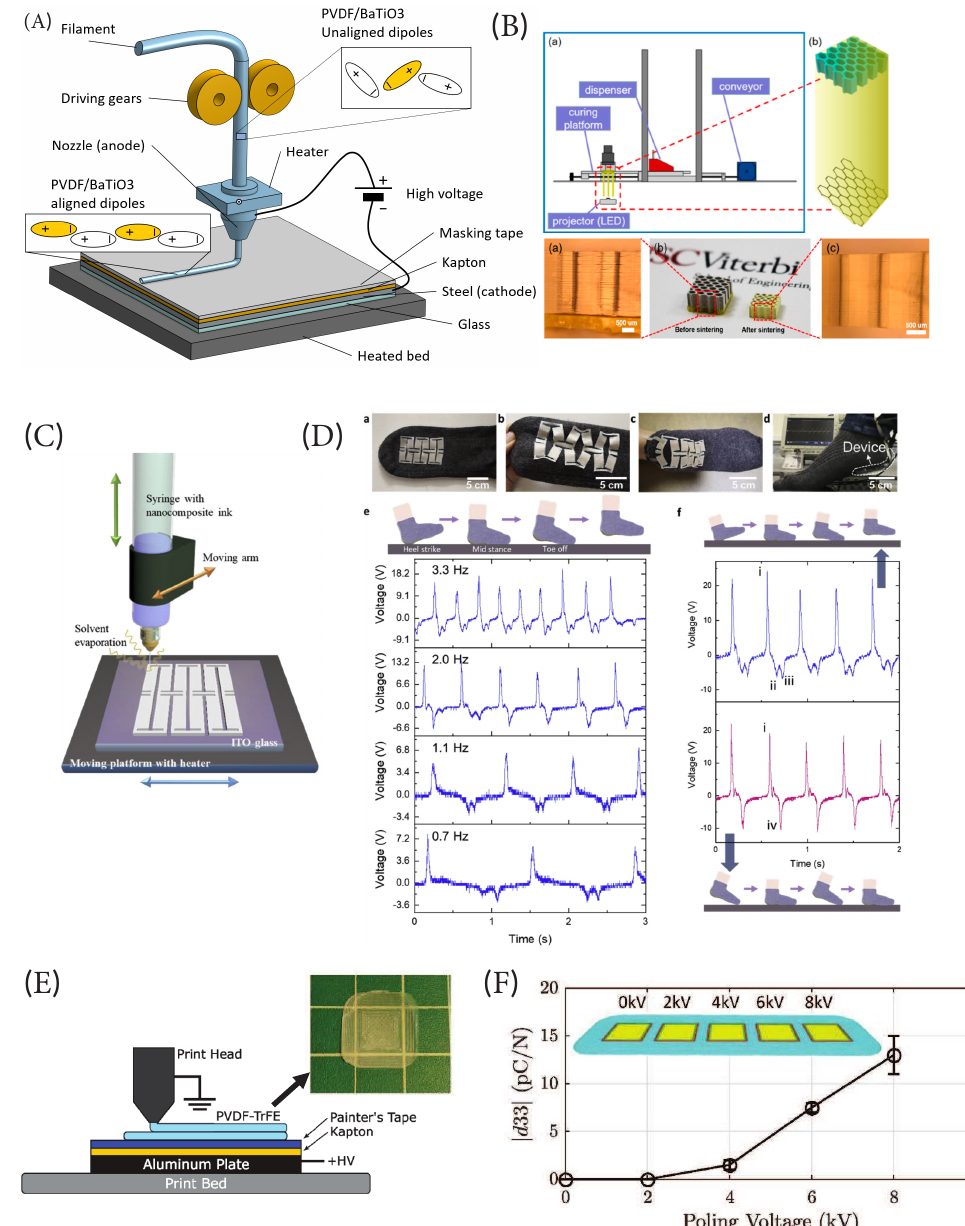
Figure 4. ( A ) Schematic of 3D printing with in situ poling of PVDF mixed wutg BTO filler as described in [113]. ( B ) Mask-Image-Projection-based Stereolithography (MIP-SL) system with piezoelectric honeycomb structure before and after sintering [103]. ( C , D ) 3DP system (DIW) and the generator mounted on a sock along with voltage output under walking with different frequency and posture [106]. ( E ) FDM system with in situ poling, 3D printed sample and ( F ) piezoelectric constant versus poling voltage [114].